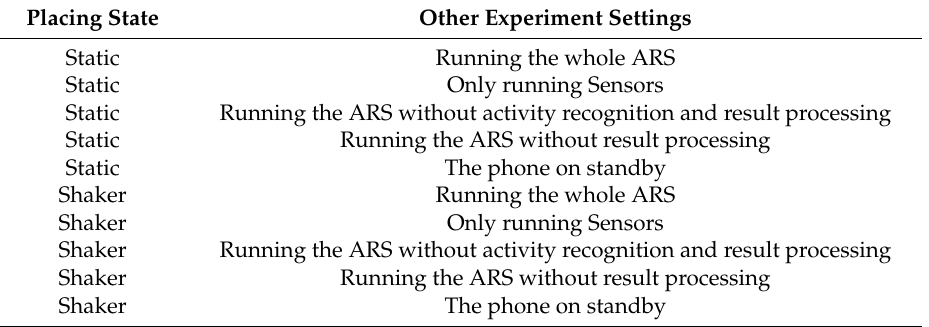
Table 5. Experiment setting of each case of study.